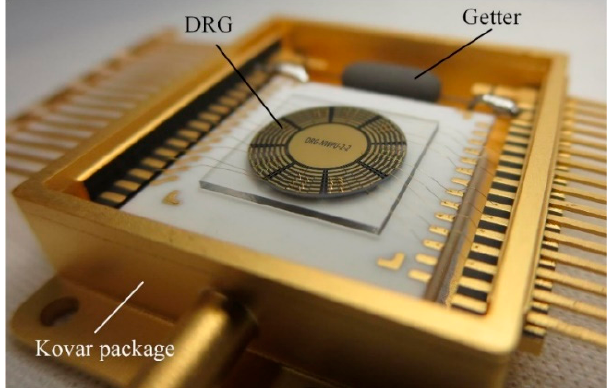
Figure 11. DRG in a Kovar package with the getter inside.